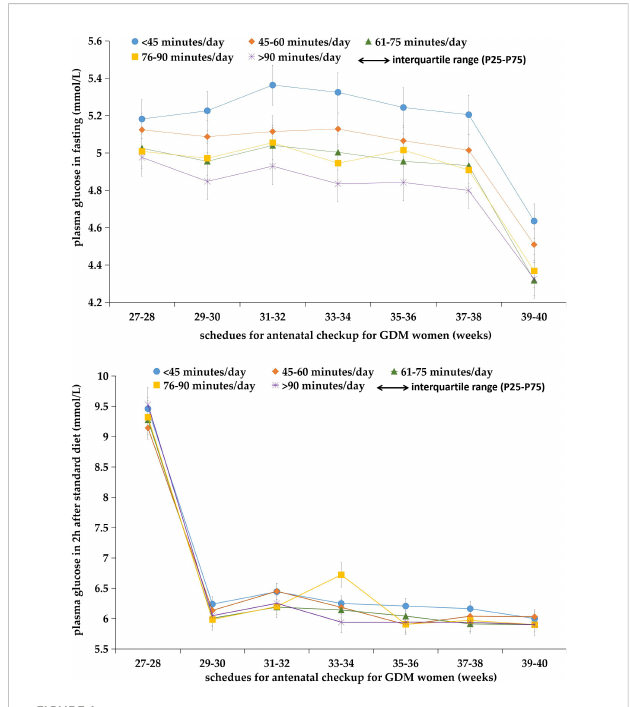
FIGURE 1 Plasma glucose levels both in fasting and 2 h after diet in GDM women with different levels of daily moderate-intensity physical exercise times at each scheduled antenatal checkup ( n =